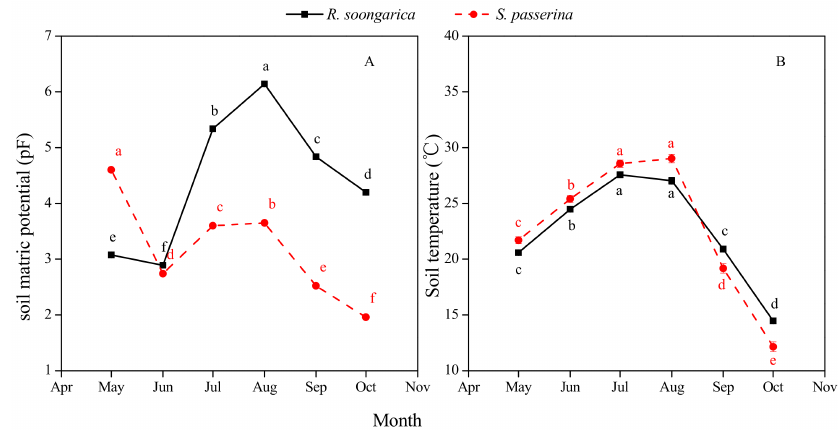
Figure 2. Seasonal changes in soil matric potential ( A ) and soil temperature ( B ) at a soil depth of 0–40 cm for R. soongorica and S. passerina . Error bars are standard errors of the mean ( n = 30 or 31). Different lowercase letters indicate significant differences among the months at p < 0.05. pF = log(-hPa);